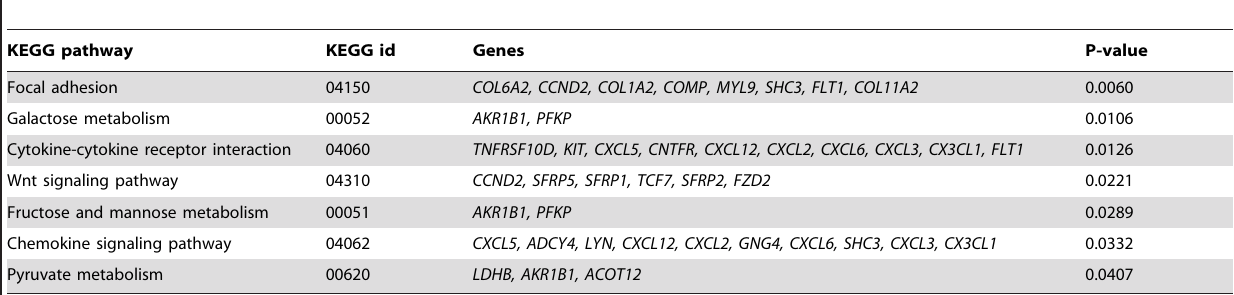
Table 3. Biological function of genes differentially methylated between the low b and the high b group of breast tumors.